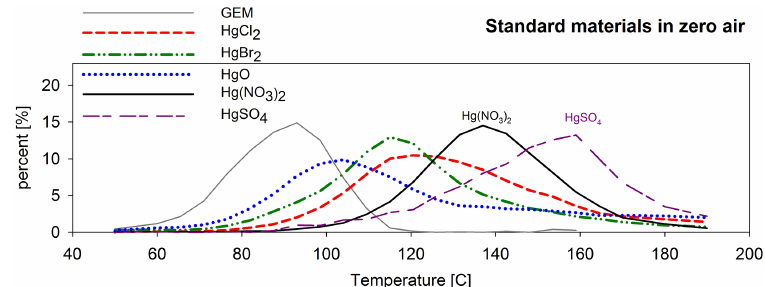
Figure 2. Thermal desorption profiles generated by permeating different Hg compounds. Modified from Huang et al. (2013). Percent indicates the amount released relative to the total. Profiles were developed in activated charcoal-scrubbed air. Compounds being permeated may not be the exact compound in the permeation tube, and this needs to be verified.